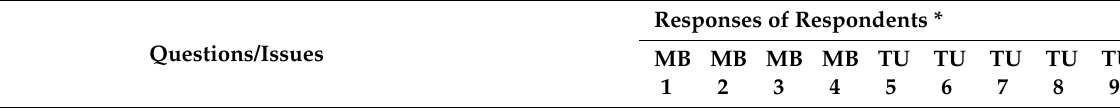
Table 2. Assessment of the functioning of ESG principles from the perspective of stakeholder